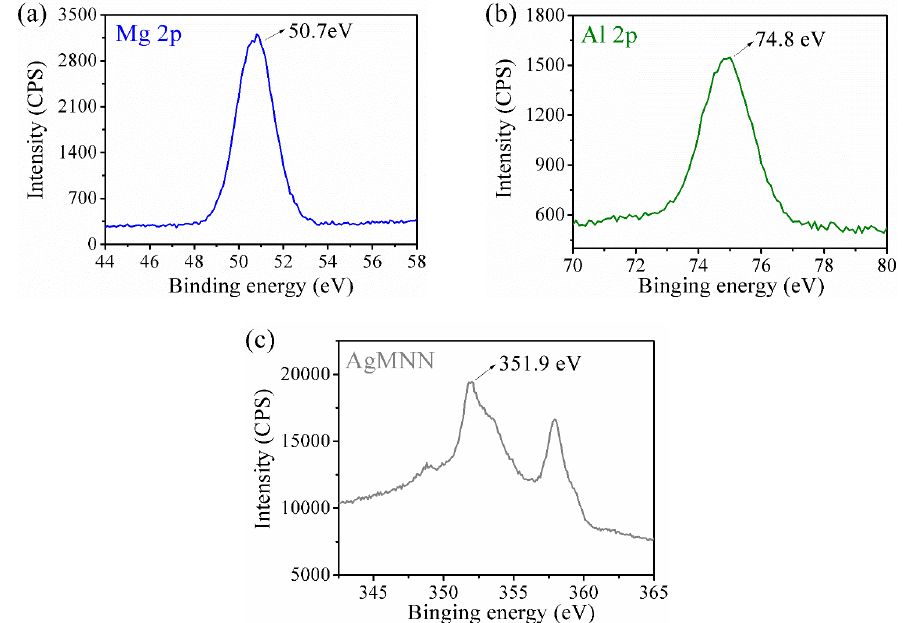
Figure 6. XPS spectra and AES spectrum of the Ag-2Mg-2Al specimen activated at 500 °C for 30 min at 20.0 Pa. ( a ) Mg 2p derived from the specimen at a depth of 10 nm; ( b ) Al 2p derive from the